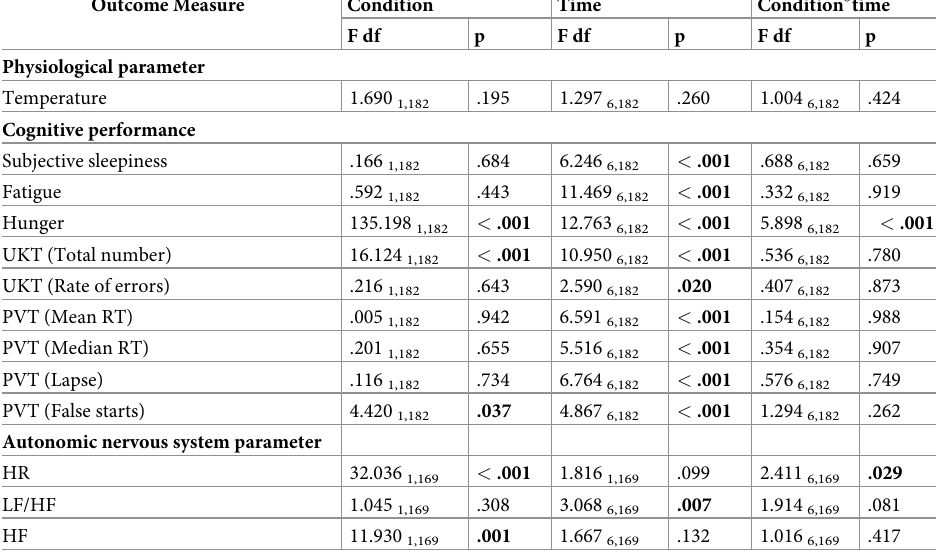
Table 2. Linear mixed models: Physiological parameters, cognitive performance, and autonomic nervous system activity outcome measures. Outcome Measure